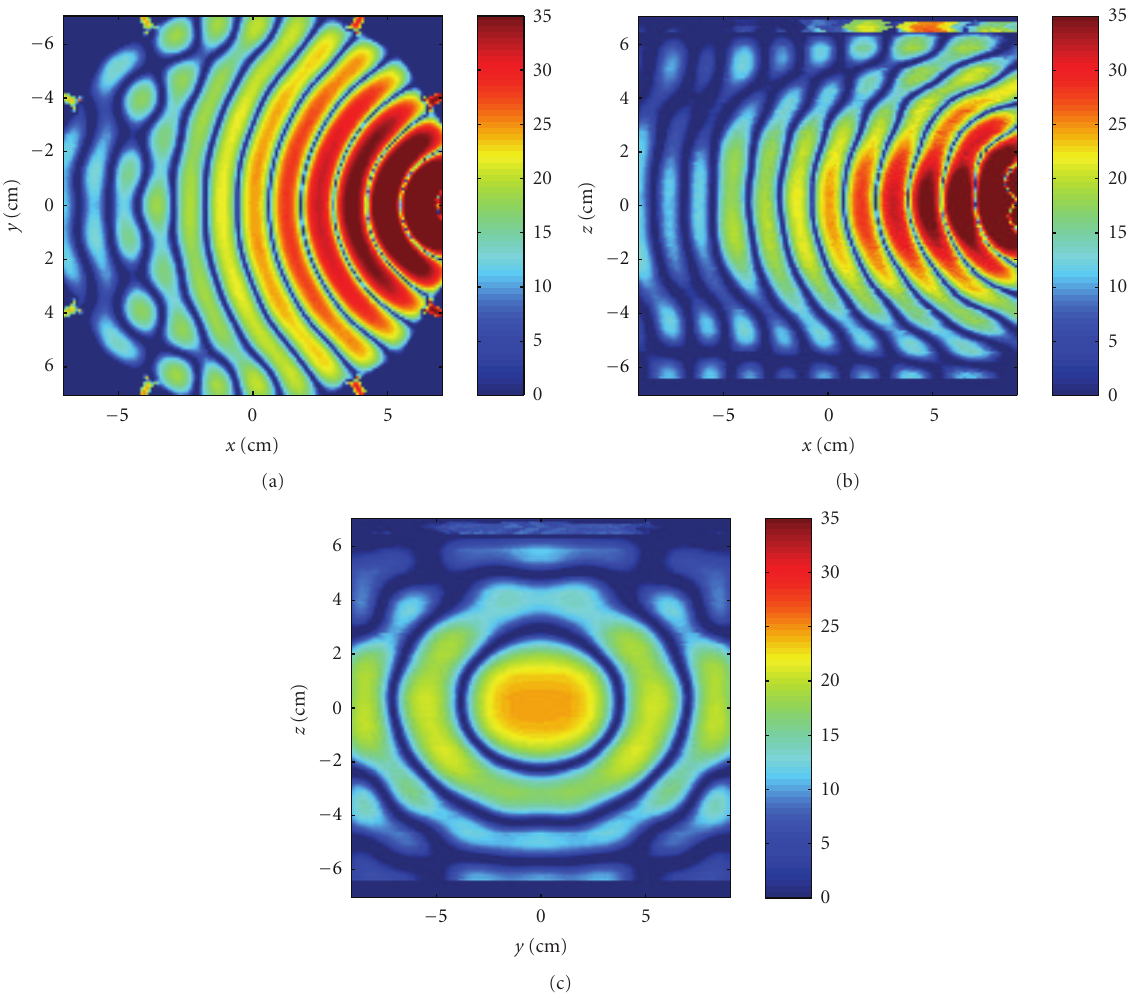
Figure 8: Crosscuts through the center of the cavity of the z -component of the incident electric field due to the middle transmitter. The scale is 20log10( | Re { E z ,inc } | ) of the unnormalized field. (a) Horizontal x - y , and (b) vertical x - z , and (c) vertical y - z